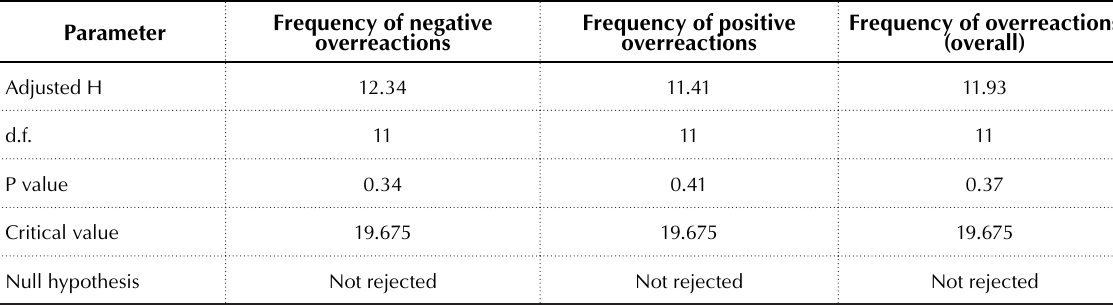
Table 9. Non-parametric Kruskal-Wallis test of monthly seasonality in overreactions frequency